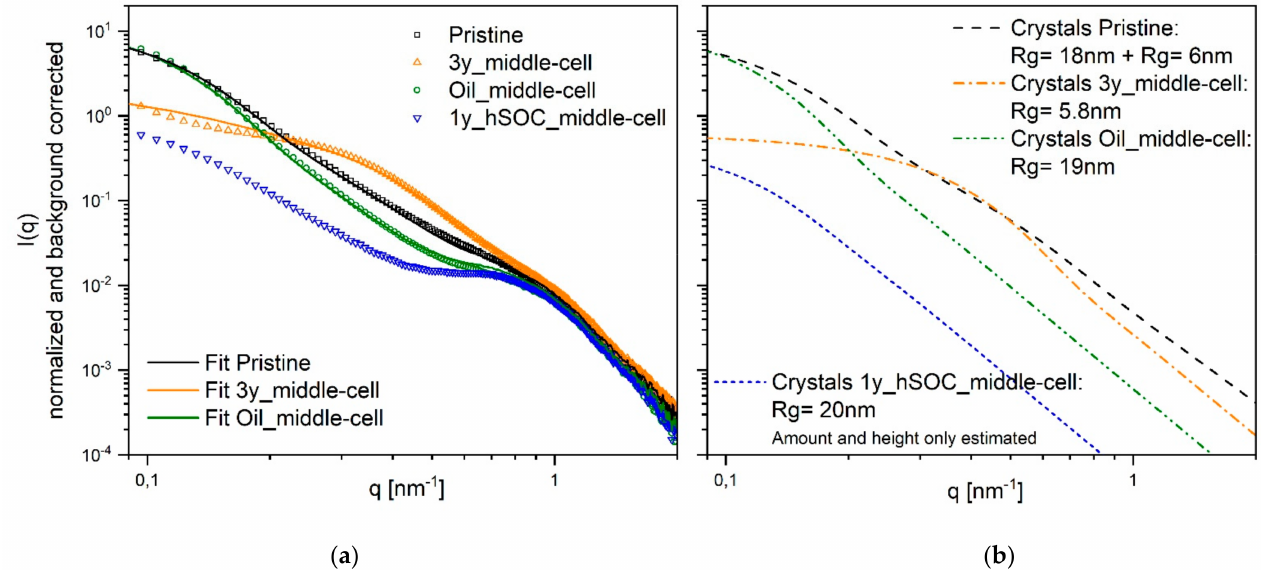
Figure 4. Selected types of SAXS pattern. ( a ): Experimental scattering patterns (points) compared to calculated pattern (solid lines) assuming a constant ionomer scattering part and a changing crystalline part, ( b ): Scattering pattern of the crystalline parts required to explain the difference in the total scattering cures shown in ( a ). For 1y_hSOC_middle-cell the amount of crystallites is only known to be small (from DSC), the average size could be determined. For the other curves, size and amount of crystallites included above the crystallites in 1y_hSOC_middle-cell could be